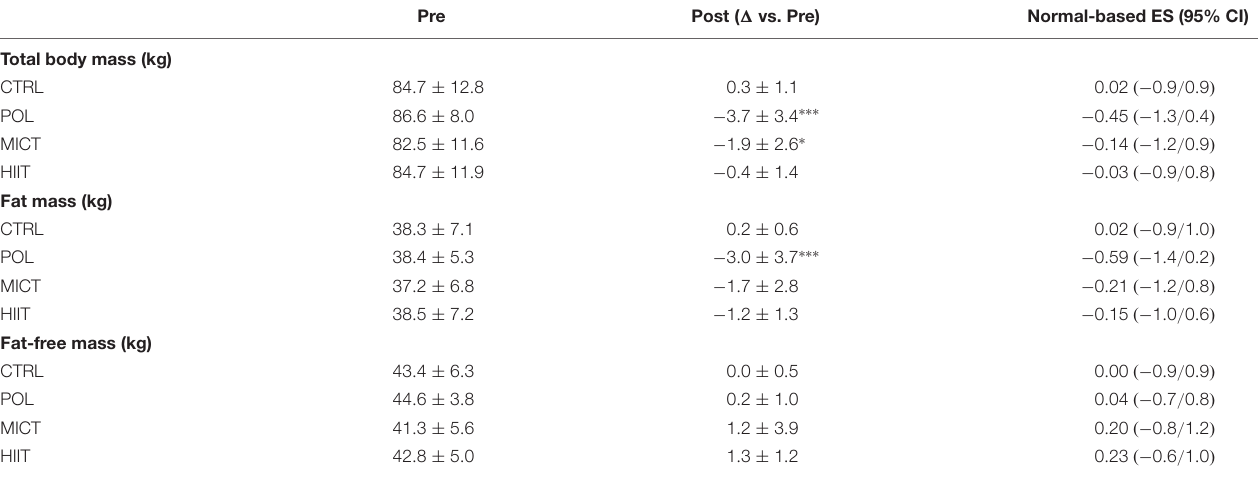
TABLE 3 | Changes in body weight and body composition after 12-weeks of intervention.